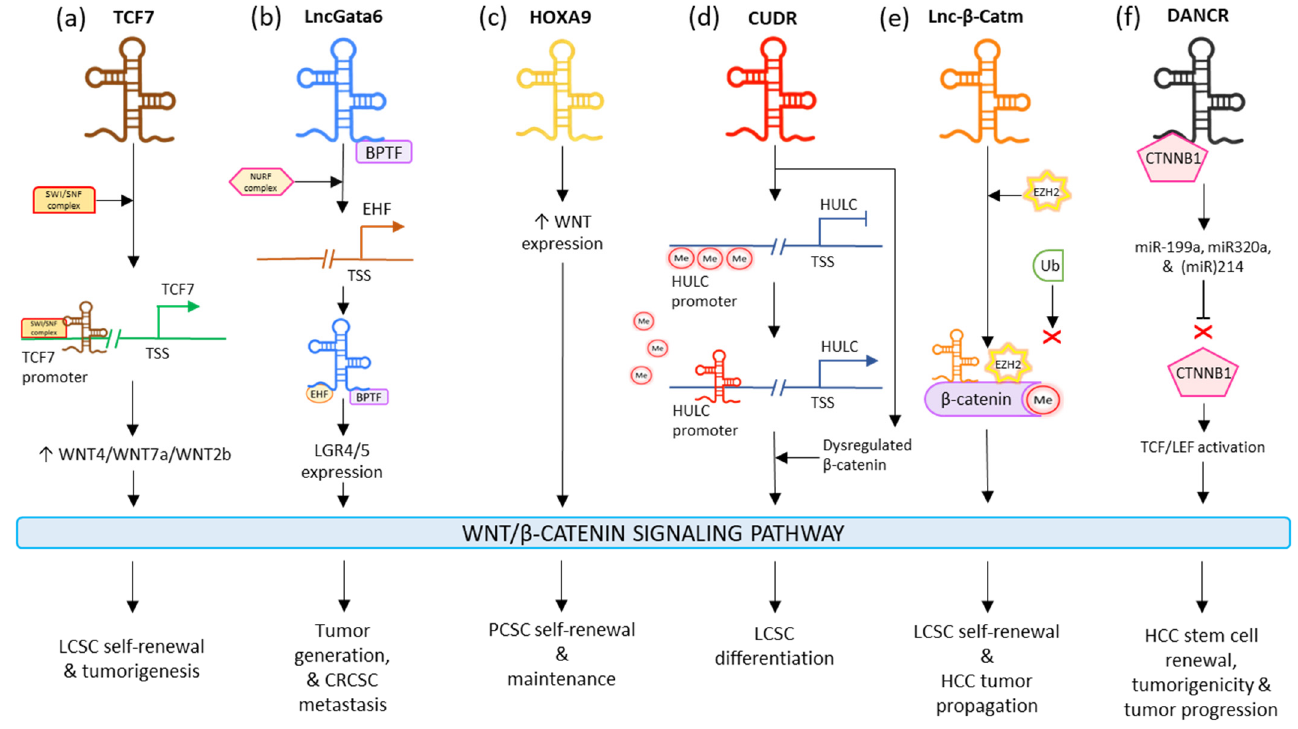
Figure 3. Influence of different lncRNAs on WNT/ β -Catenin CSC signaling pathway.